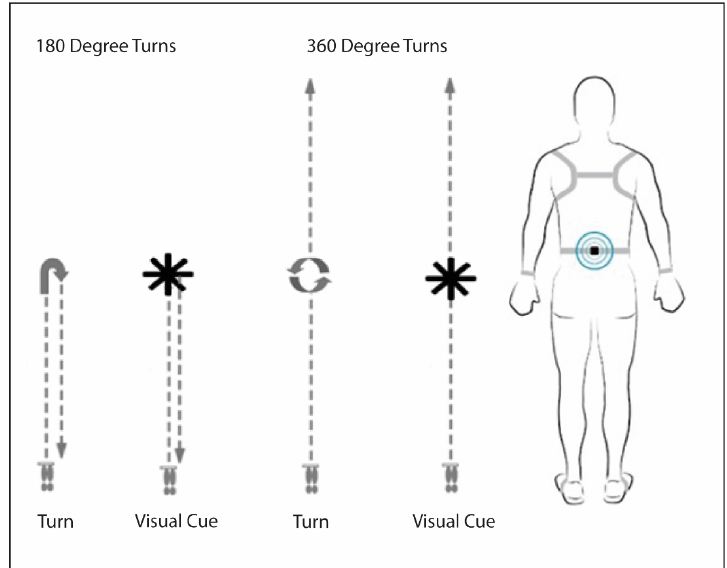
Figure 1. Turning conditions with and without visual cue, and IMU placement.